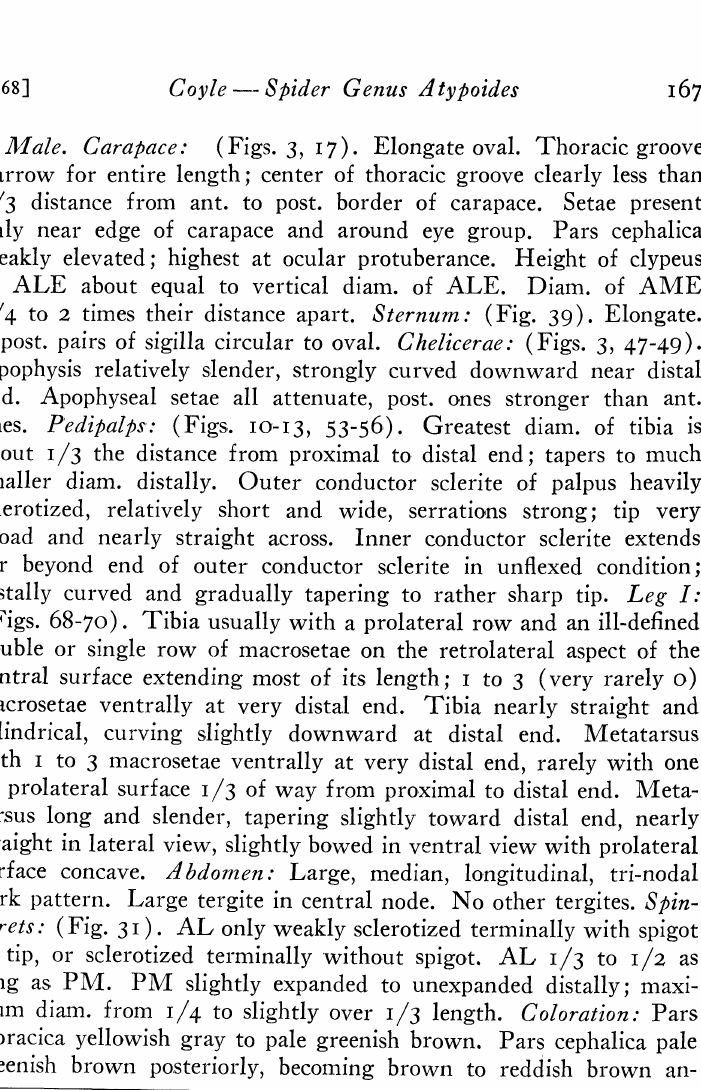
Figs. 16-21. Eyes (dorsal view with lateral border of carapace hori- zontal). 16-17. /. riversi. 16. Q from C. 17. 6 paralectotype, from (7. 18-19. /. hadros. 18. ? paratype, from type locality. 19. 6 holotype. 20-21. A. tTertschi. 20. ? paratype, from O. 21. $ holotype. [0.5 mm scale line for